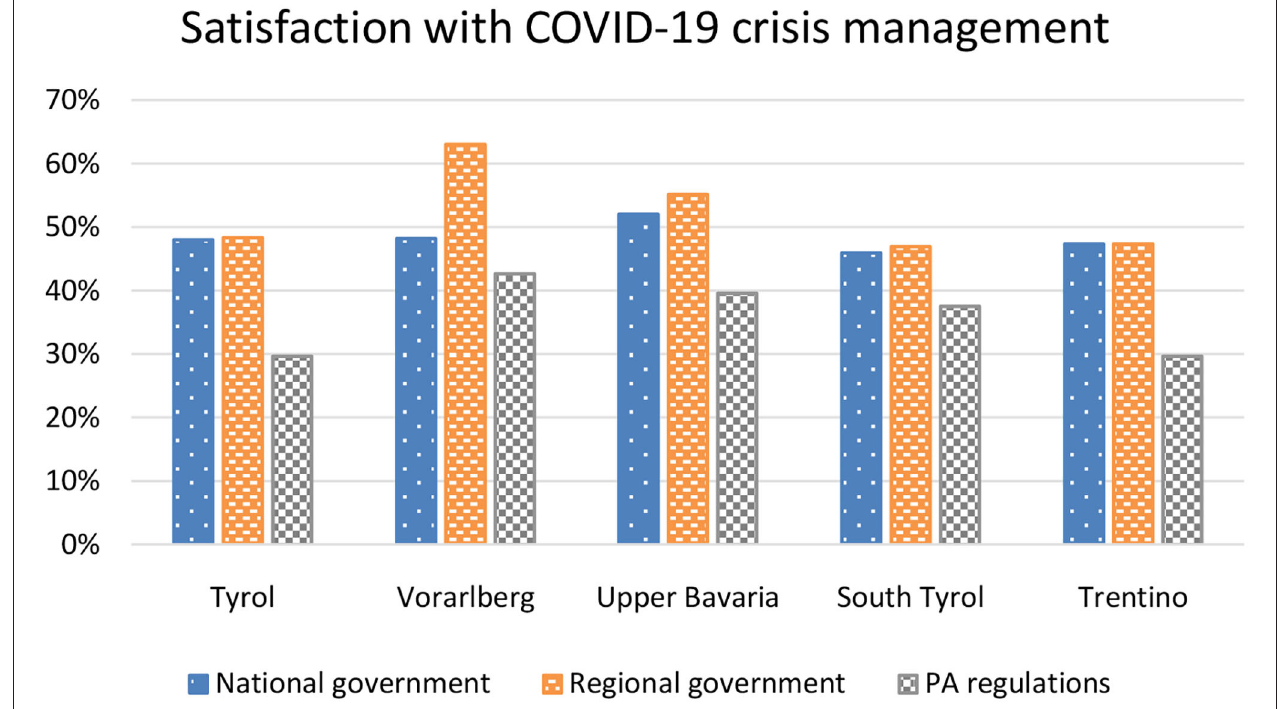
FIGURE 3 | Satisfaction of participants from the five Alpine regions with the COVID-19 crisis management of their national governments, their regional governments and the PA regulations their governments had